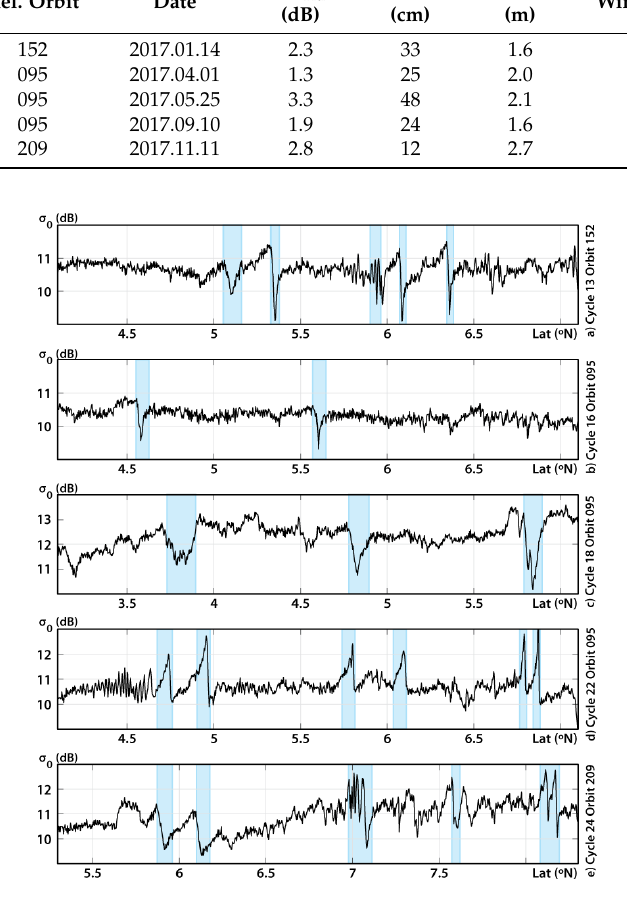
Figure 5. Selection of Sentinel-3A SRAL observations (Ku-band) over the tropical Atlantic Ocean off the Amazon shelf where signatures of surface manifestations of ISWs can be identified (in light blue rectangles, see also Table 1 for